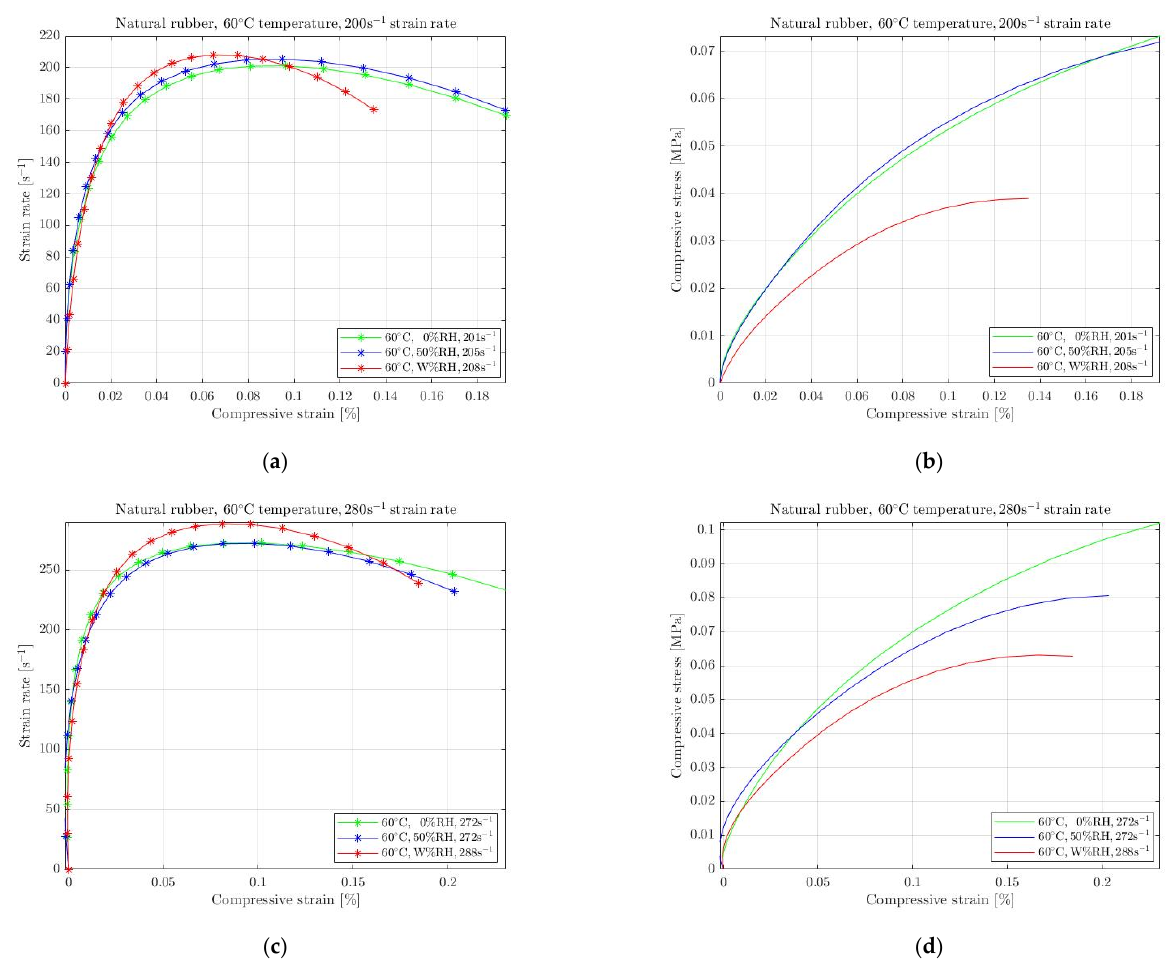
Figure 11. Strain rate vs. compressive strain ( a , c ) and compressive stress vs. compressive strain ( b , d ) of natural rubber under compression at 60 °C temperature with 0%, 50% and W% RH for 200 s − 1 ( b , d ) of natural rubber under compression at 60 ◦ C temperature with 0%, 50% and W% RH for ( a , b ) and 280 s − 1 ( c , d ) strain rate. 200 s − 1 ( a , b ) and 280 s − 1 ( c , d ) strain